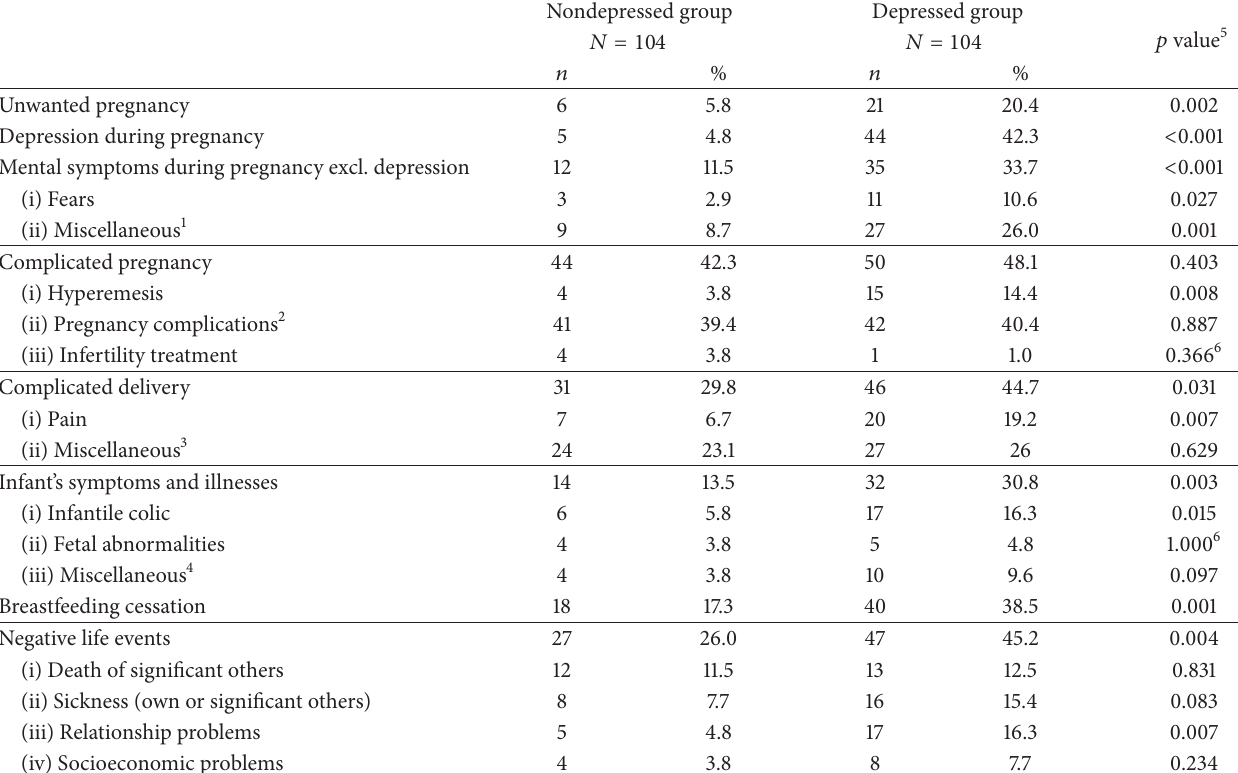
Table 1: Adverse experiences during the antenatal and postnatal period in the nondepressed and depressed group. Nondepressed group